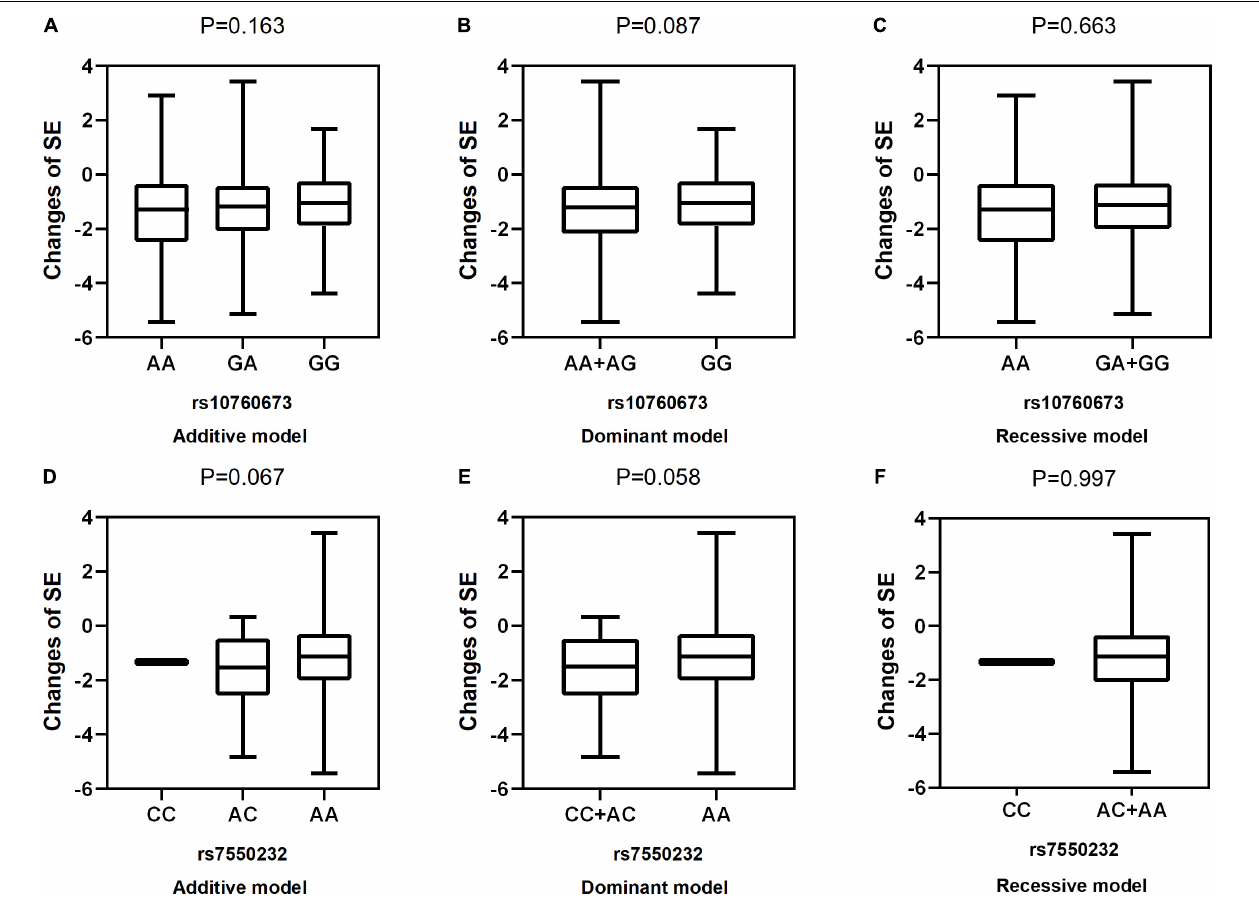
FIGURE 2 | Correlations between the two SNPs and the changes in SE. rs10760673 [ (A) additive model, p = 0.163; (B) dominant model, p = 0.087; (C) recessive model, p = 0.663]; rs7550232 [ (D) additive model, p = 0.067; (E) dominant model, p = 0.058; (F) recessive model, p = 0.997].